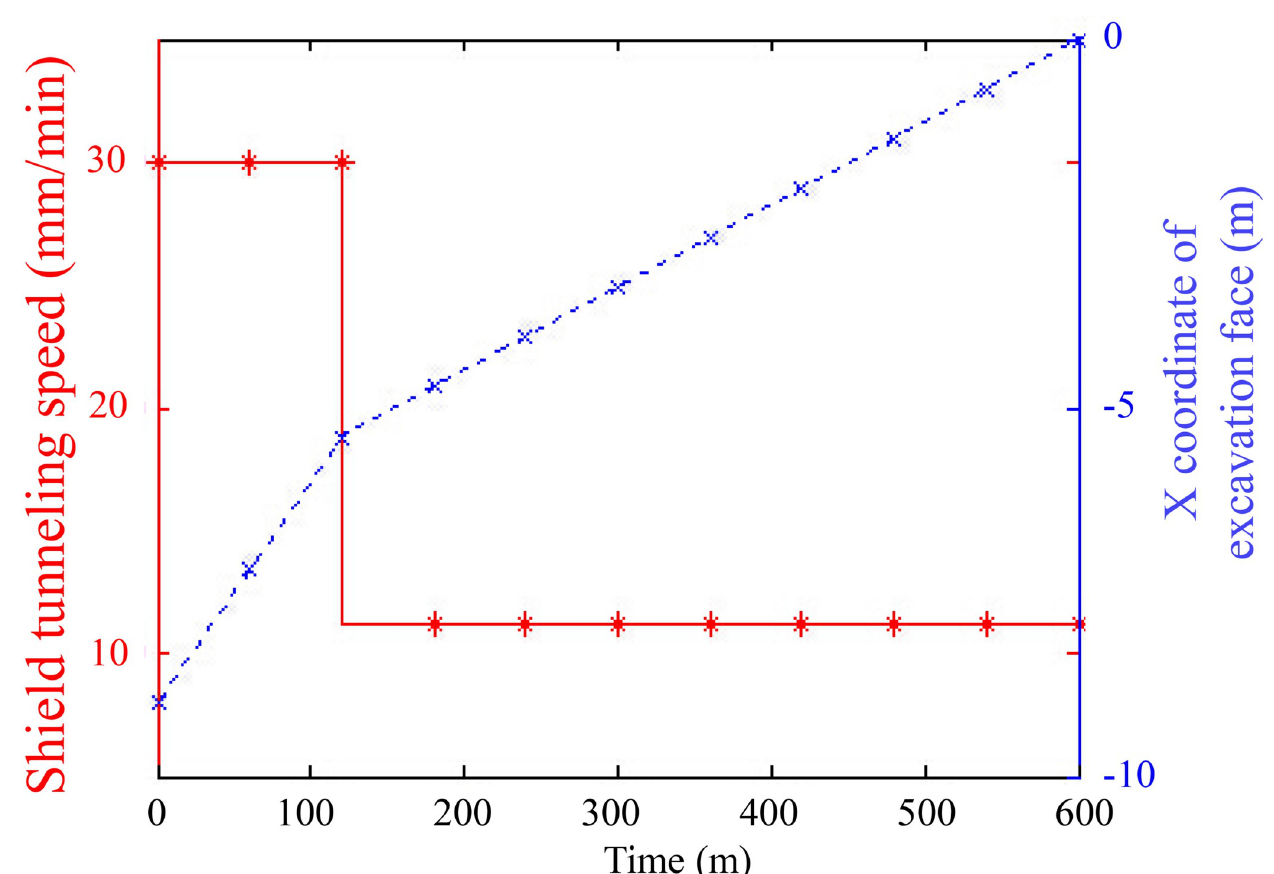
Fig 6. Optimal shield tunneling speed and corresponding displacement.